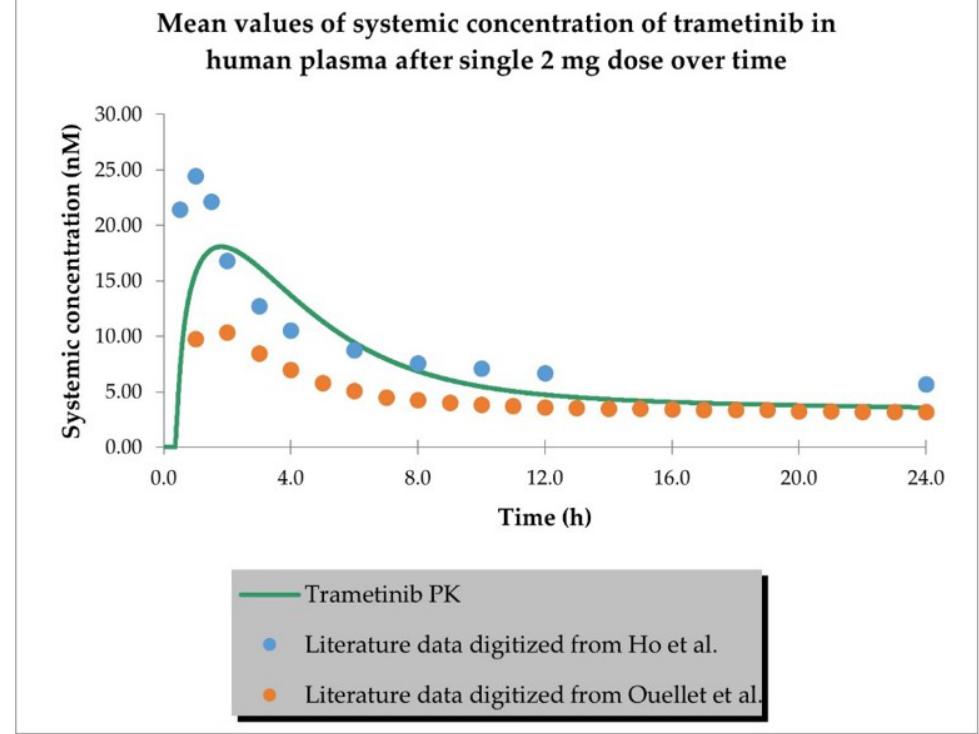
Figure 2. PBPK model of trametinib after a single dose in cancer patient representative. Observed data are presented as means from literature data (digitised from Ho et al. [30] and Ouellet et al. [31] as indicated in Table